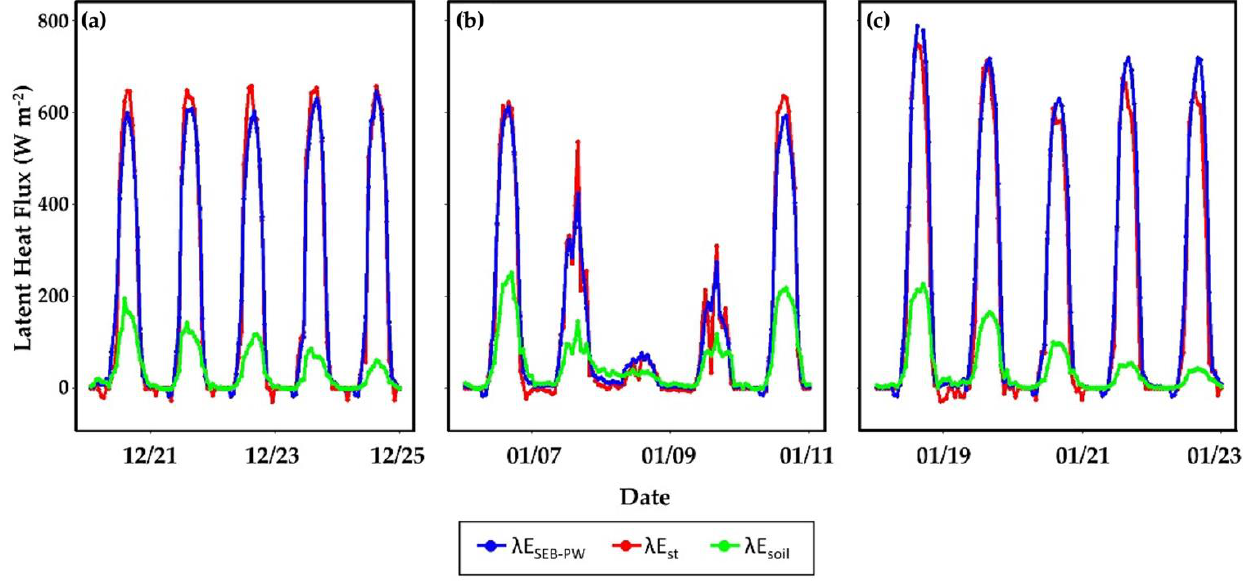
Figure 7. ET and E estimated by the SEB –PW model (λE SEB-PW and λE soil ), and ET measured by the ET station (λE st ) during three field campaigns ( a – c ) at site S1 during the 2018 – 2019 growing season. At site S2, t he diurnal dynamics of λE estimated with the SEB -PW model and meas- ured with the ET station at site S2 were similar to those at site S1. At this site, λE flux reached a maximum of 670 W m −2 on 11 January (sunny) and a minimum of 500 W m −2 on 12 January (cloudy). ET values estimated with the SEB-PW model were slightly higher than the values measured with the ET station, mainly between the hours of 13:00 and 15:00. λE soil was lower at site S2 than at site S1 due to a smaller wetted soil fraction with drip (S2) than with micro-sprinklers (S1).